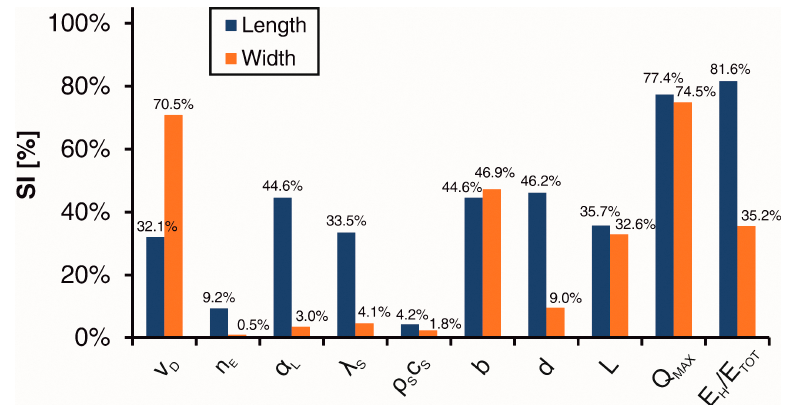
Figure 10. Sensitivity index (SI) values for each parameter of the sensitivity analysis, for plume length and width after 50-year simulations. and width after 50-year